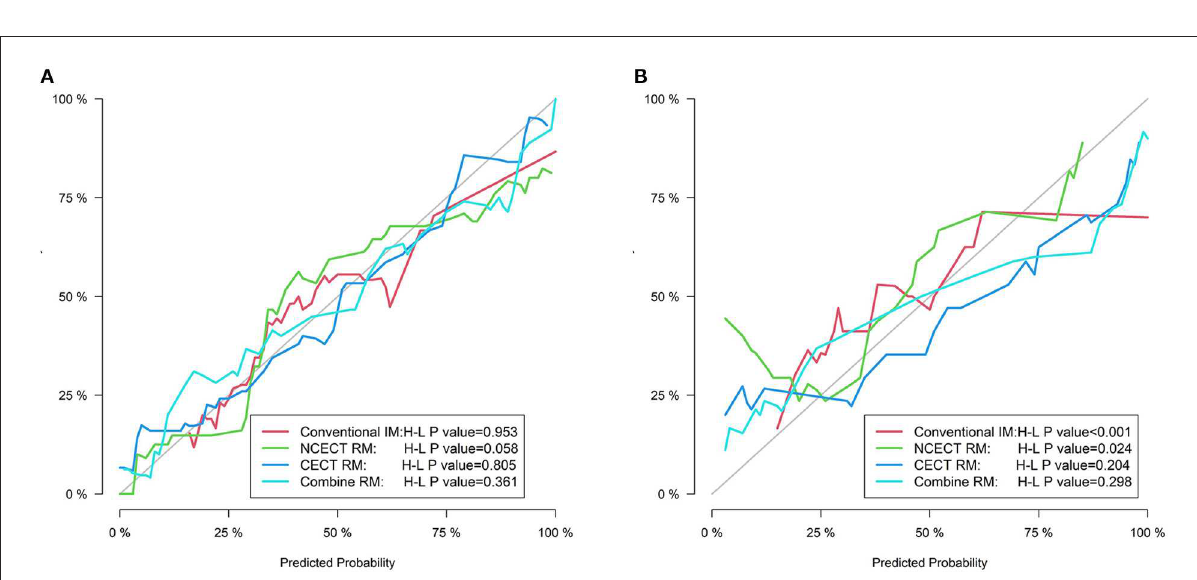
FIGURE4 The calibration curves for four models in the training set (A) and the test set (B) . The gray line represents the ideal prediction effect, and The colored lines represent the prediction effect of each model. The closer the colored line is to the gray line indicates a better fit of the model.